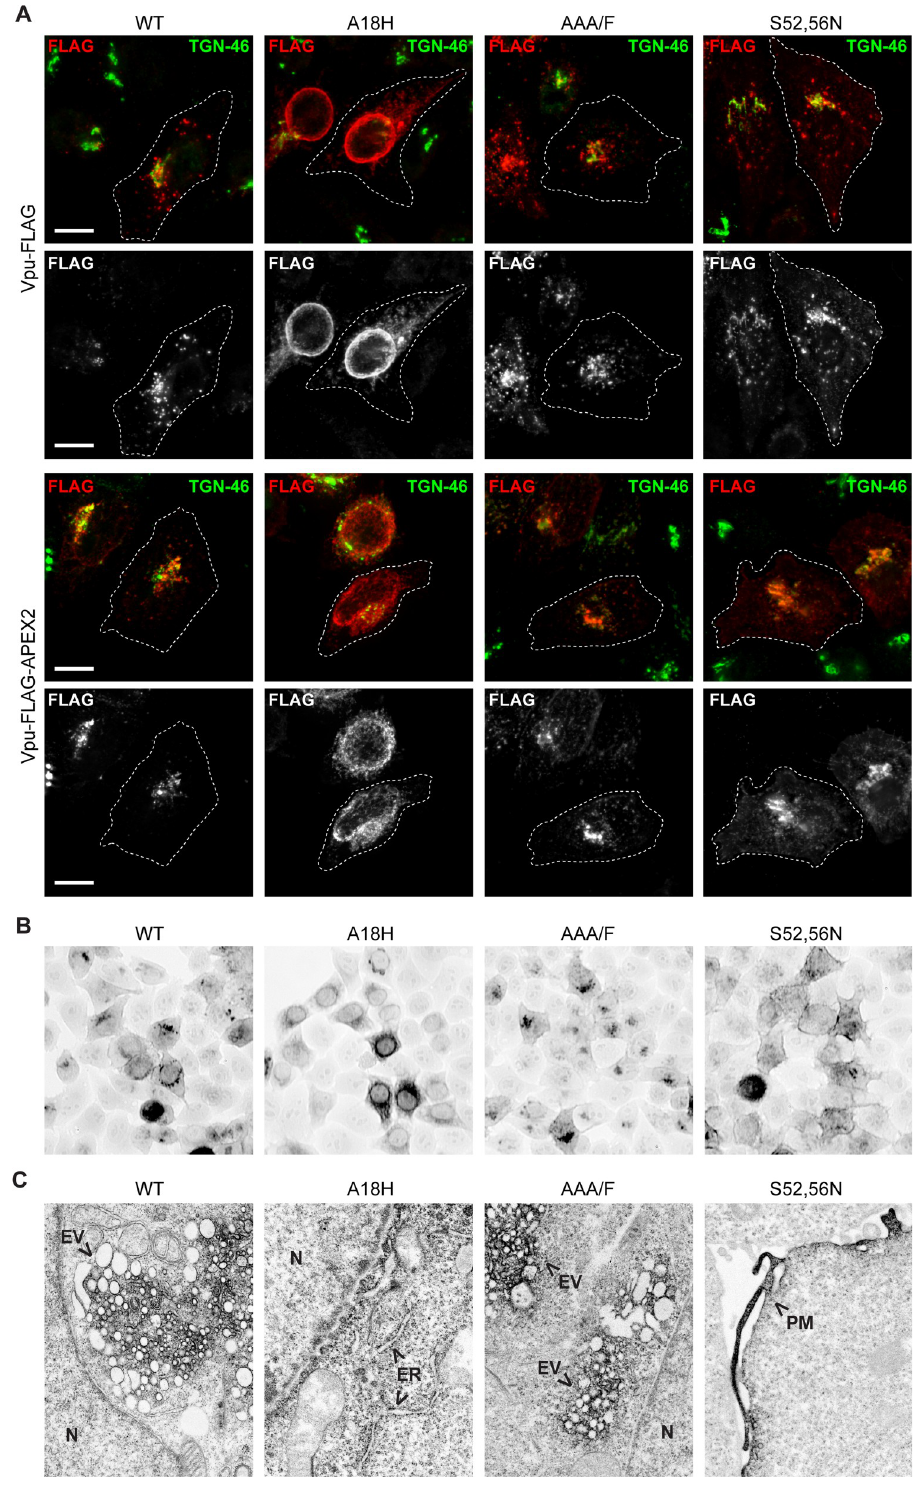
Fig 3. Light and electron microscopic distributions of Vpu-APEX2 and mutants A18H, AAA/F, and S52,56N. (A) HeLa P4.R5 cells were transfected to express Vpu-FLAG or Vpu-FLAG-APEX2, either wild type or encoding the mutations A18H, AAA/F, or S52,56N. The cells were fixed and stained for FLAG (shown in red) and TGN-46 (shown in green). (B) HeLa P4.R5 cells were transfected to express Vpu WT and the indicated mutants tagged with APEX2; 24